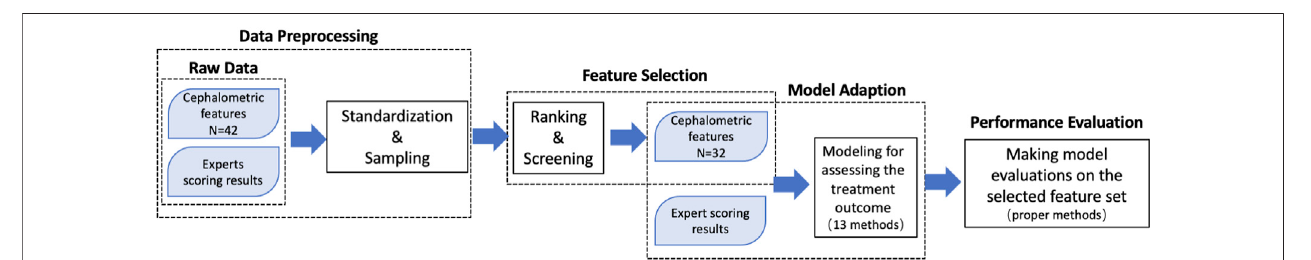
Frontiers in Physiology |